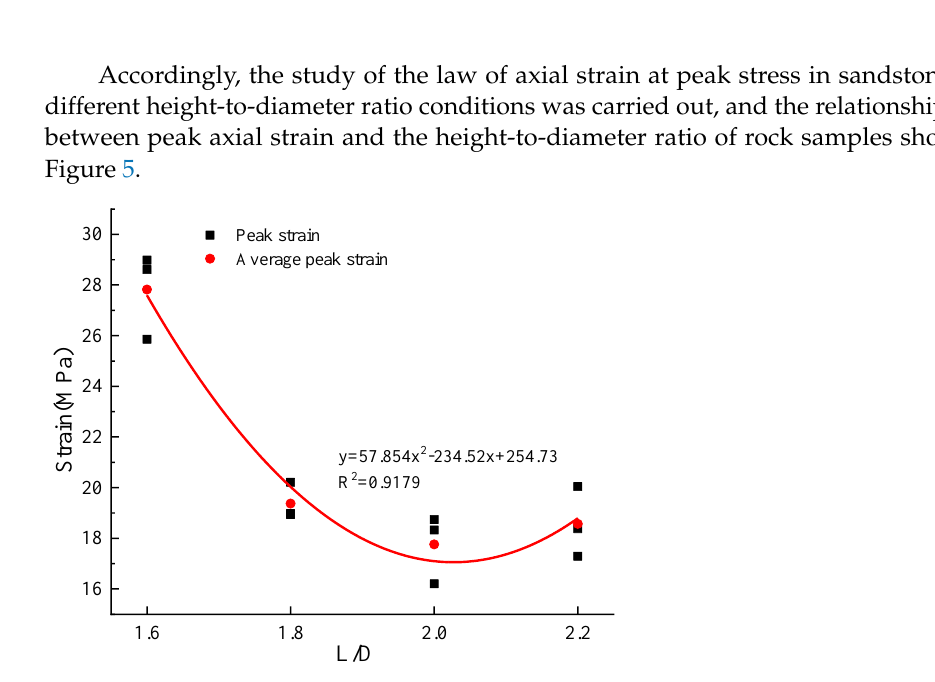
Figure 5. Peak strain of rock samples with different ratios of height−to−diameter.